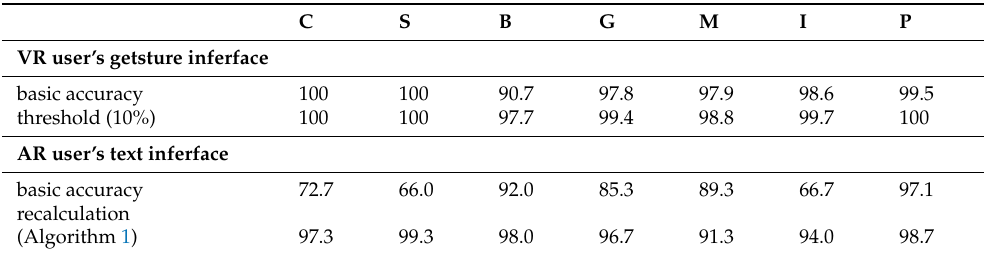
Table 4. Accuracy analysis result in the action inference process (unit: